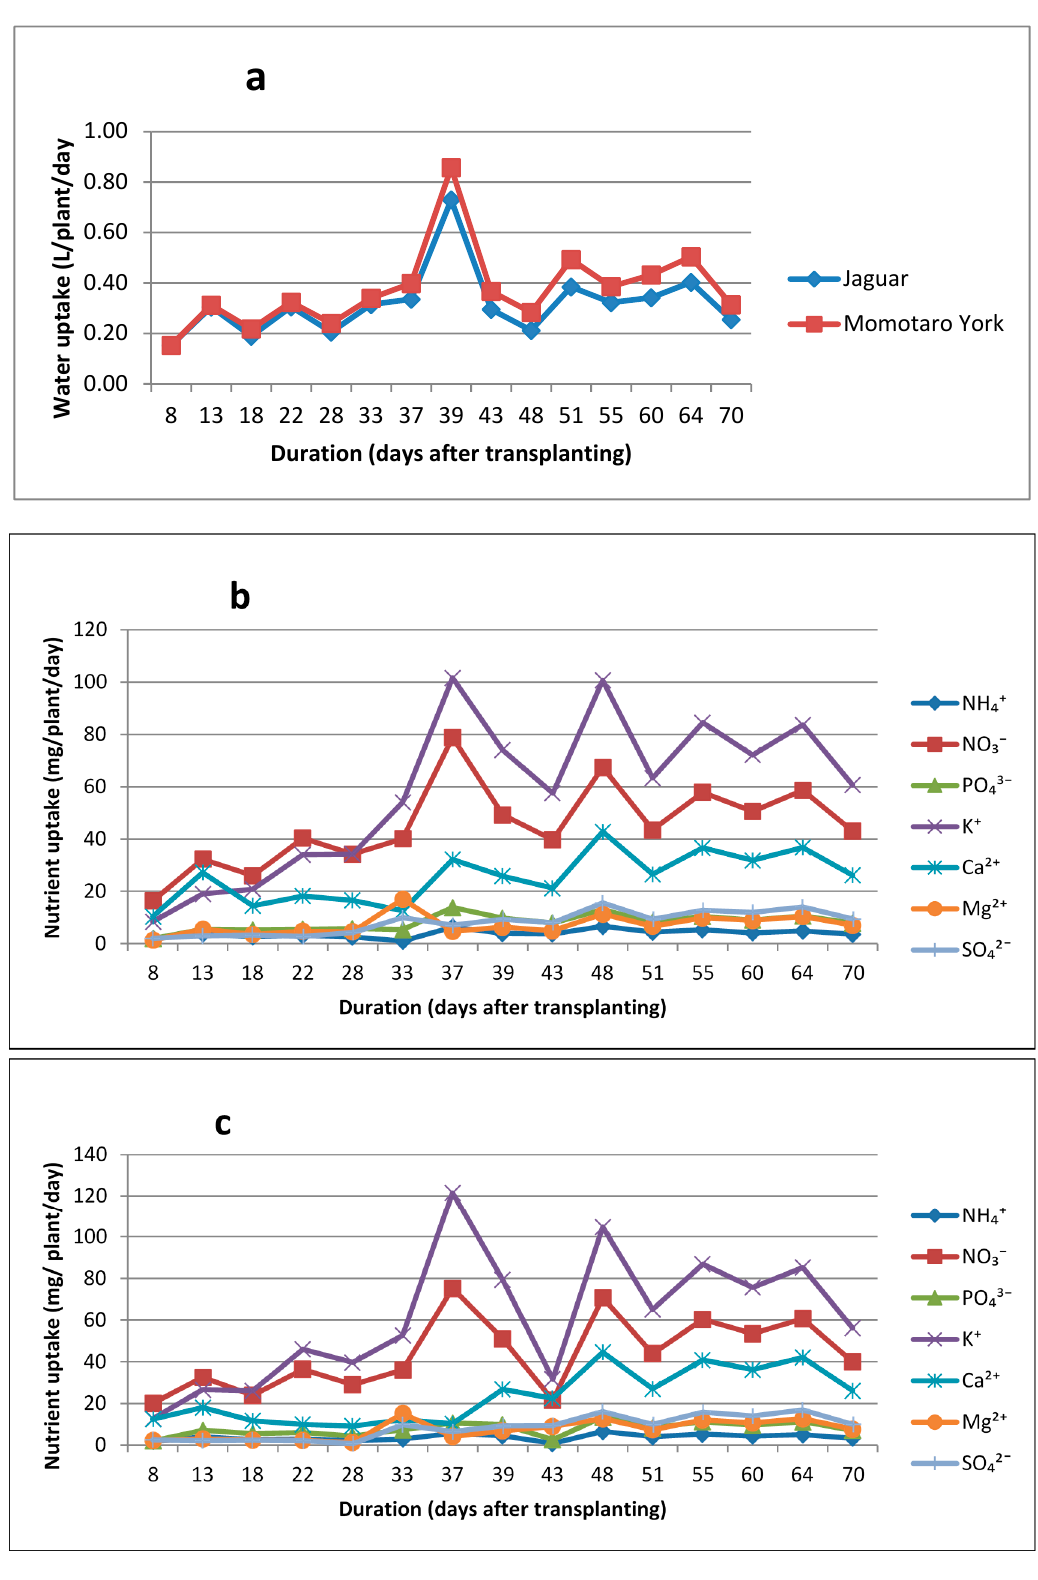
Figure 1. ( a ) Water uptake characteristics of Jaguar and Momotaro York, ( b ) nutrient uptake characteristics of Jaguar, and ( c ) nutrient uptake characteristics of Momotaro York.